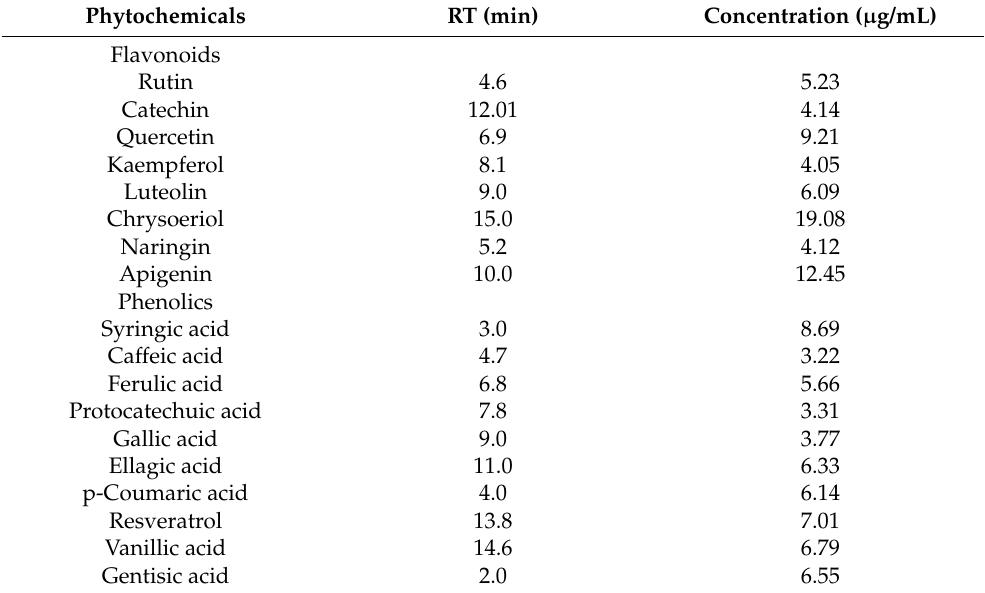
Table 2. HPLC results of the flavonoids and phenolics present in Astragalus membranaceus extract (AME) used in the present study. Phytochemicals RT (min) Concentration ( µ g/mL) Flavonoids